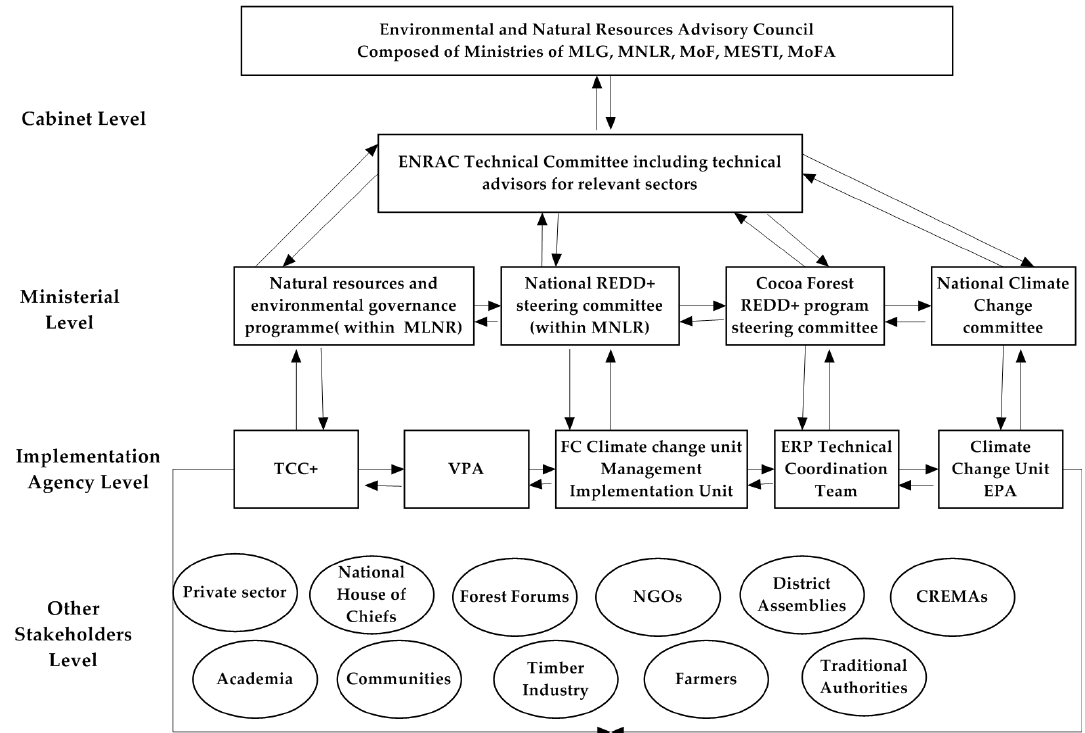
Figure 5. REDD+ Institutional Framework for Ghana. MLG: Ministry of Local Government; MLNR: Ministry of Lands and Natural Resource Management; MoF: Ministry of Finance; MESTI: Ministry of Environment, Science, Technology and Innovation; MoFA: Ministry of Food and Agriculture; TCC+: Technical Coordination Committee; VPA, Voluntary Partnership Agreements; FC: Forestry Commission; ERP: Emission Reduction Programme; EPA: Environmental Protection Agency; NGOs: Non-Governmental Organisations; CREMAs: Community Resource Management Areas. Source: Adapted from Forestry Commission, 2015 [64]. Table 1. Characteristics of REDD+ in Ghana and Nigeria.